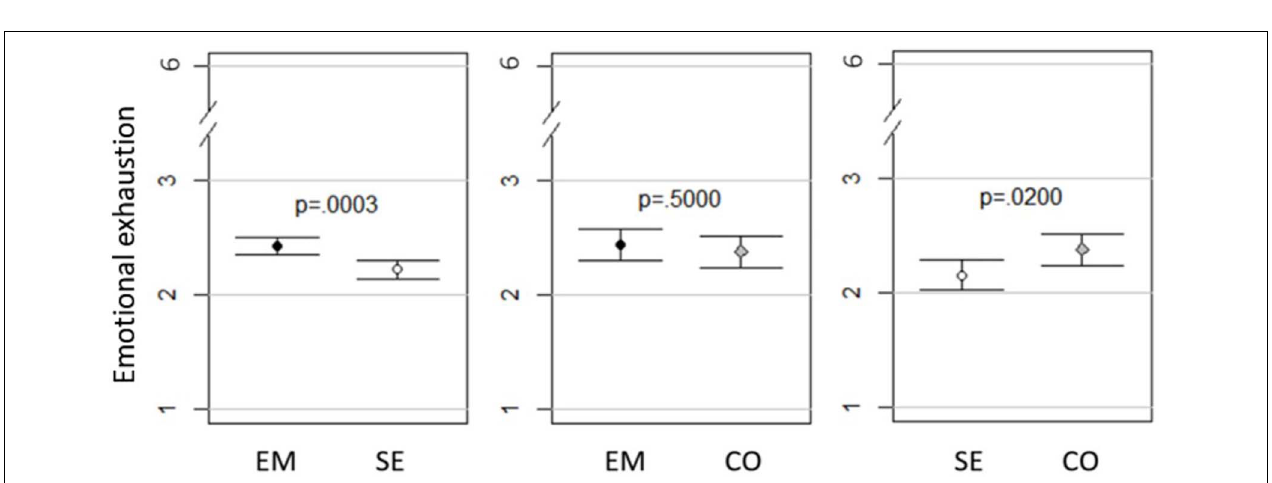
FIGURE 1 | Mean depressive symptoms with 95% Cl and p -values in employed (EM), self-employed workers (SE), and combinators (CO).